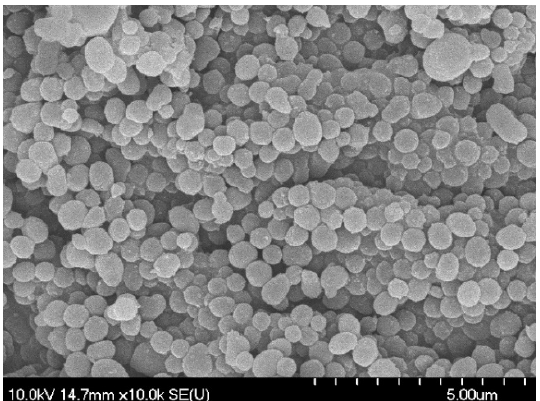
Figure 5. Typical SEM micrograph of samples H2_HS_2-4 before calcination.